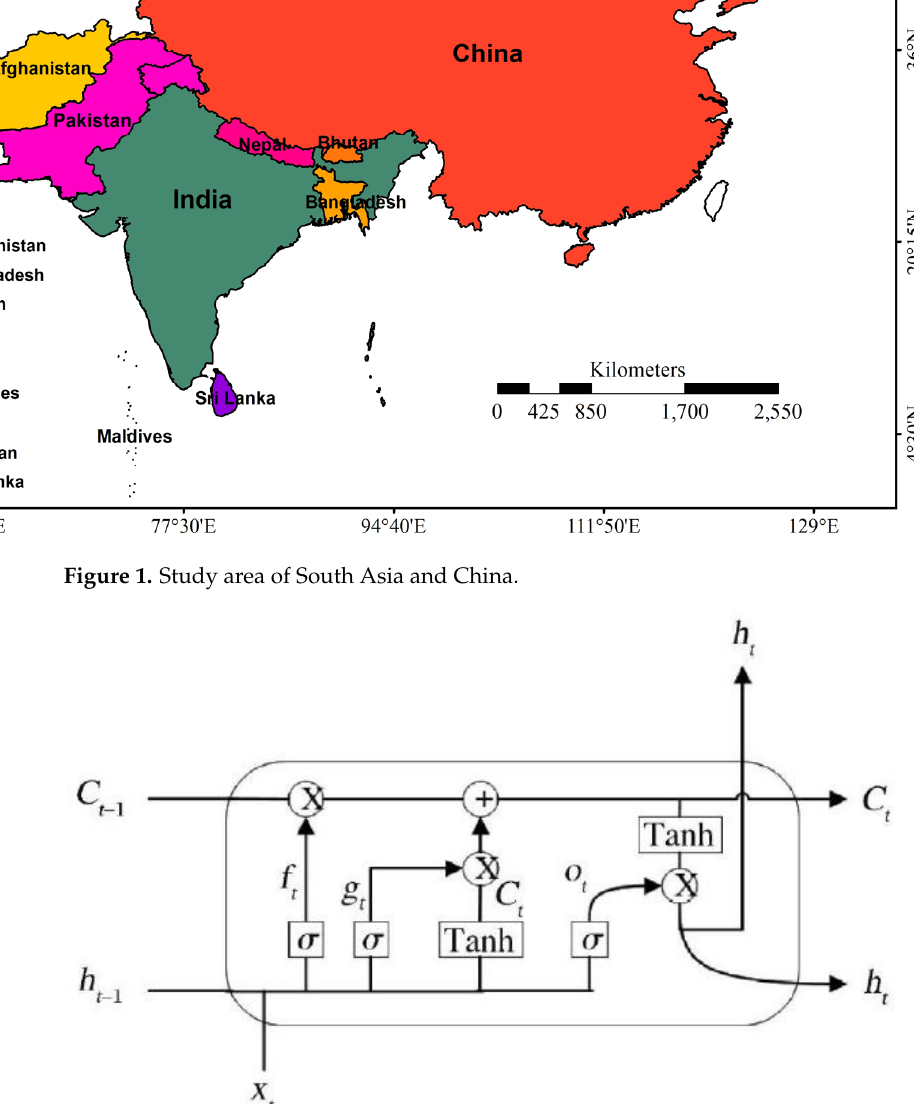
Figure 2. LSTM implementation model [37].